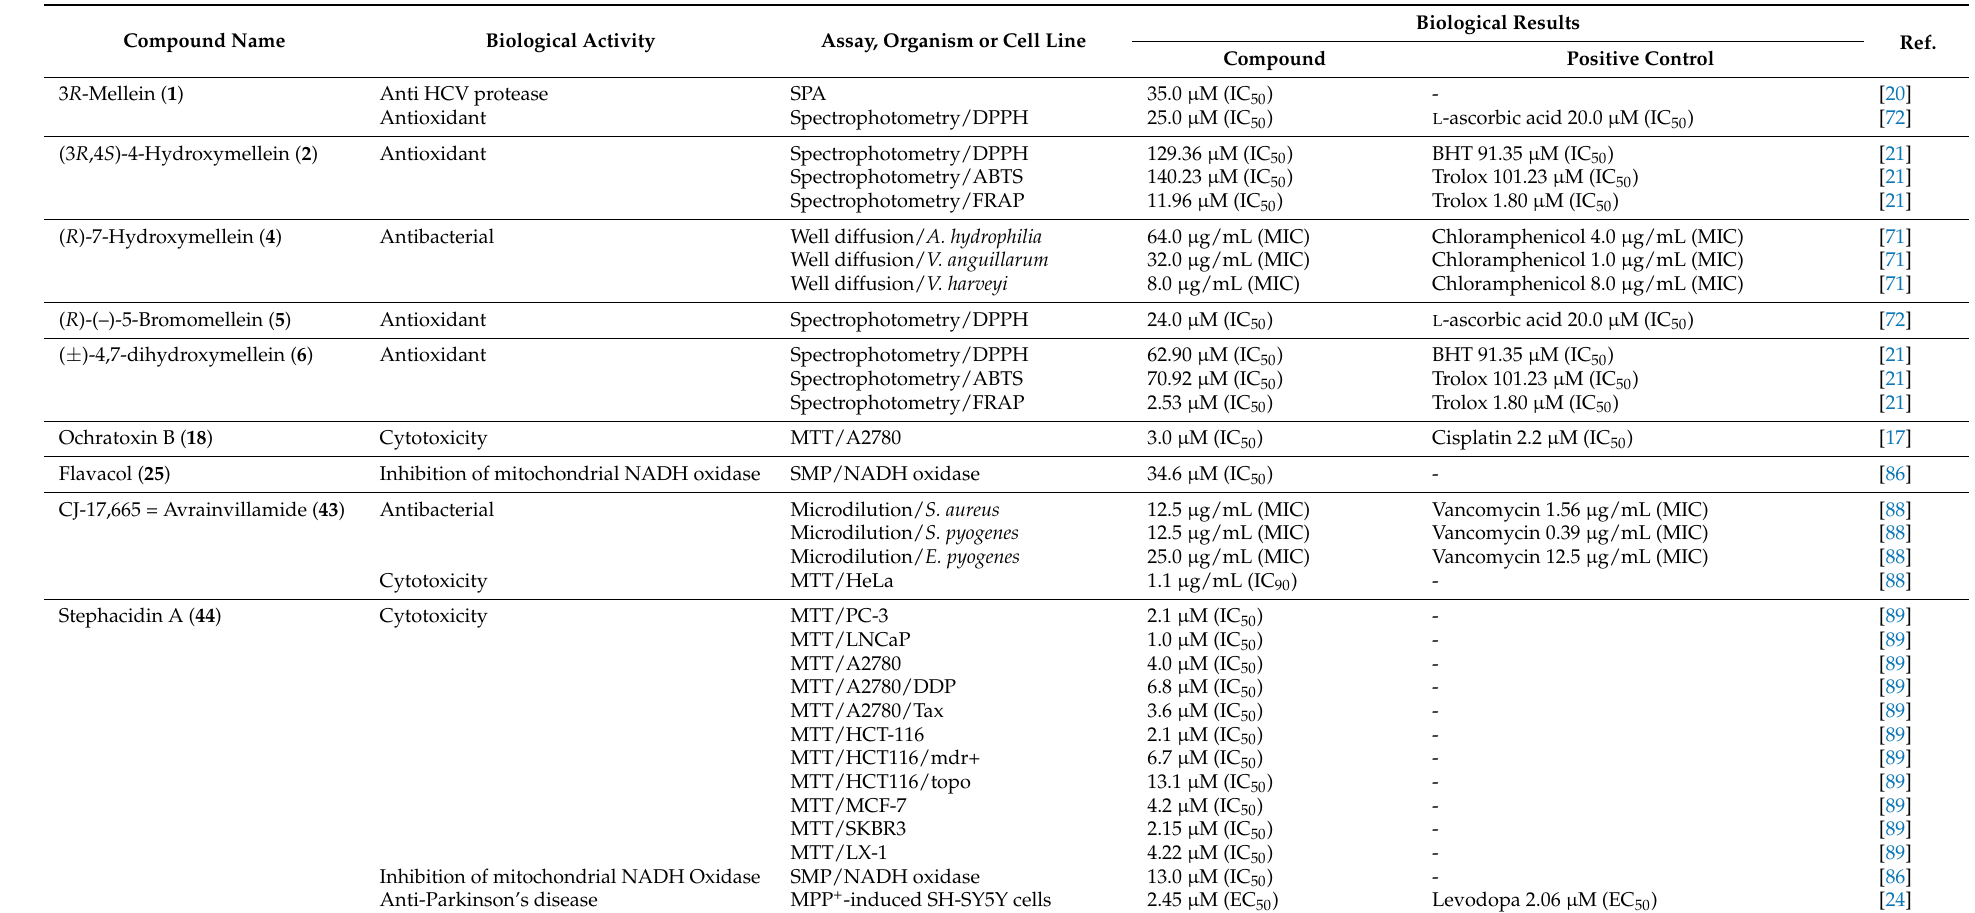
Table 2. Biological activity of reported metabolites from Aspergillus ochraceus